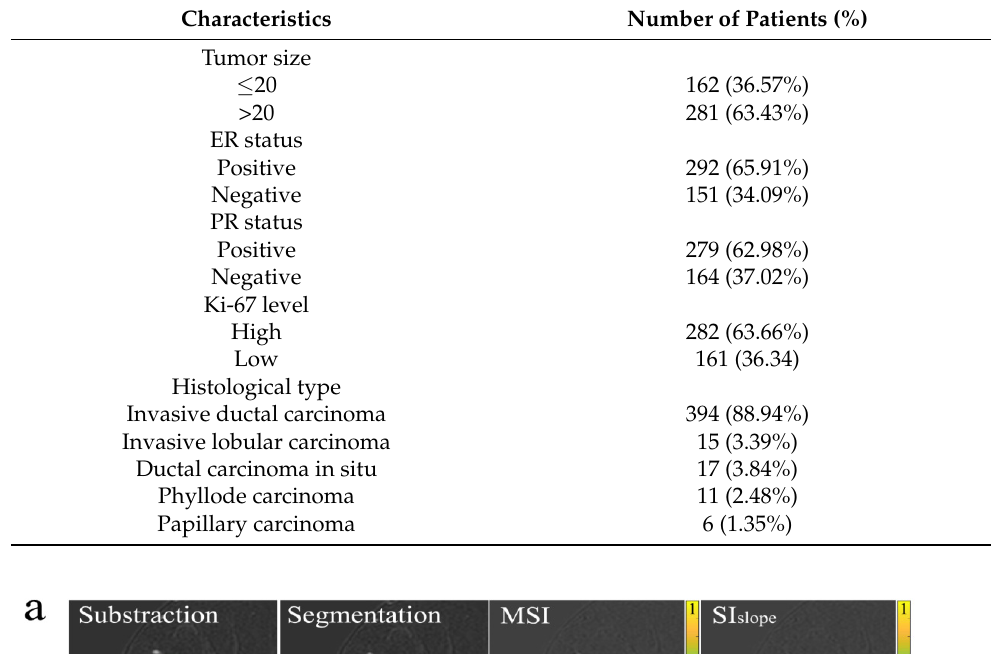
Table 1. The characteristics of 443 BC patients.